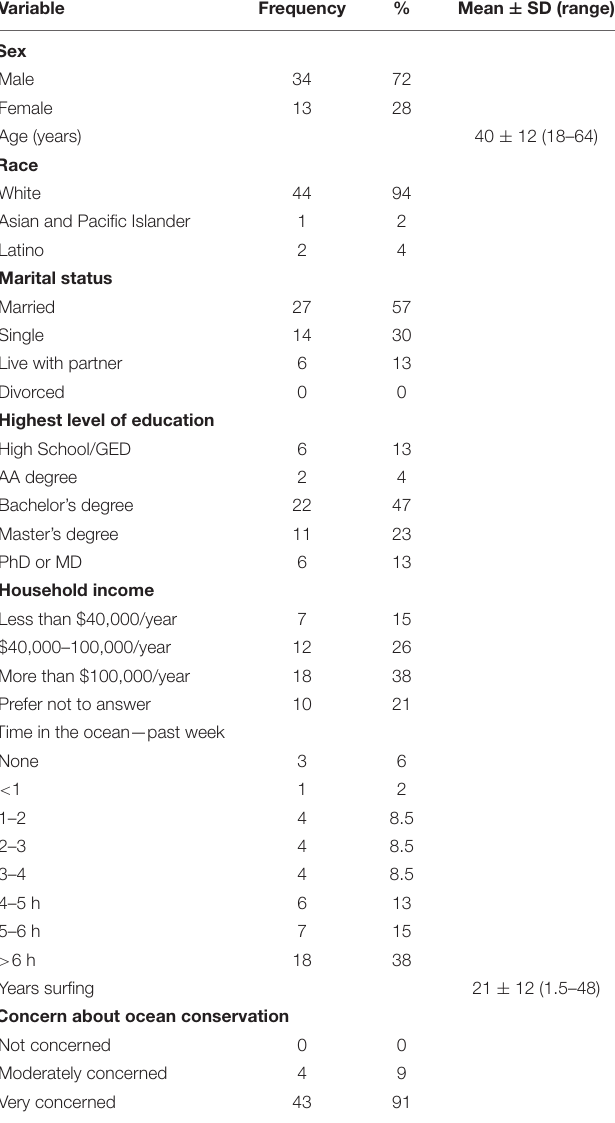
TABLE 1 | Characteristics of the study participants ( N =